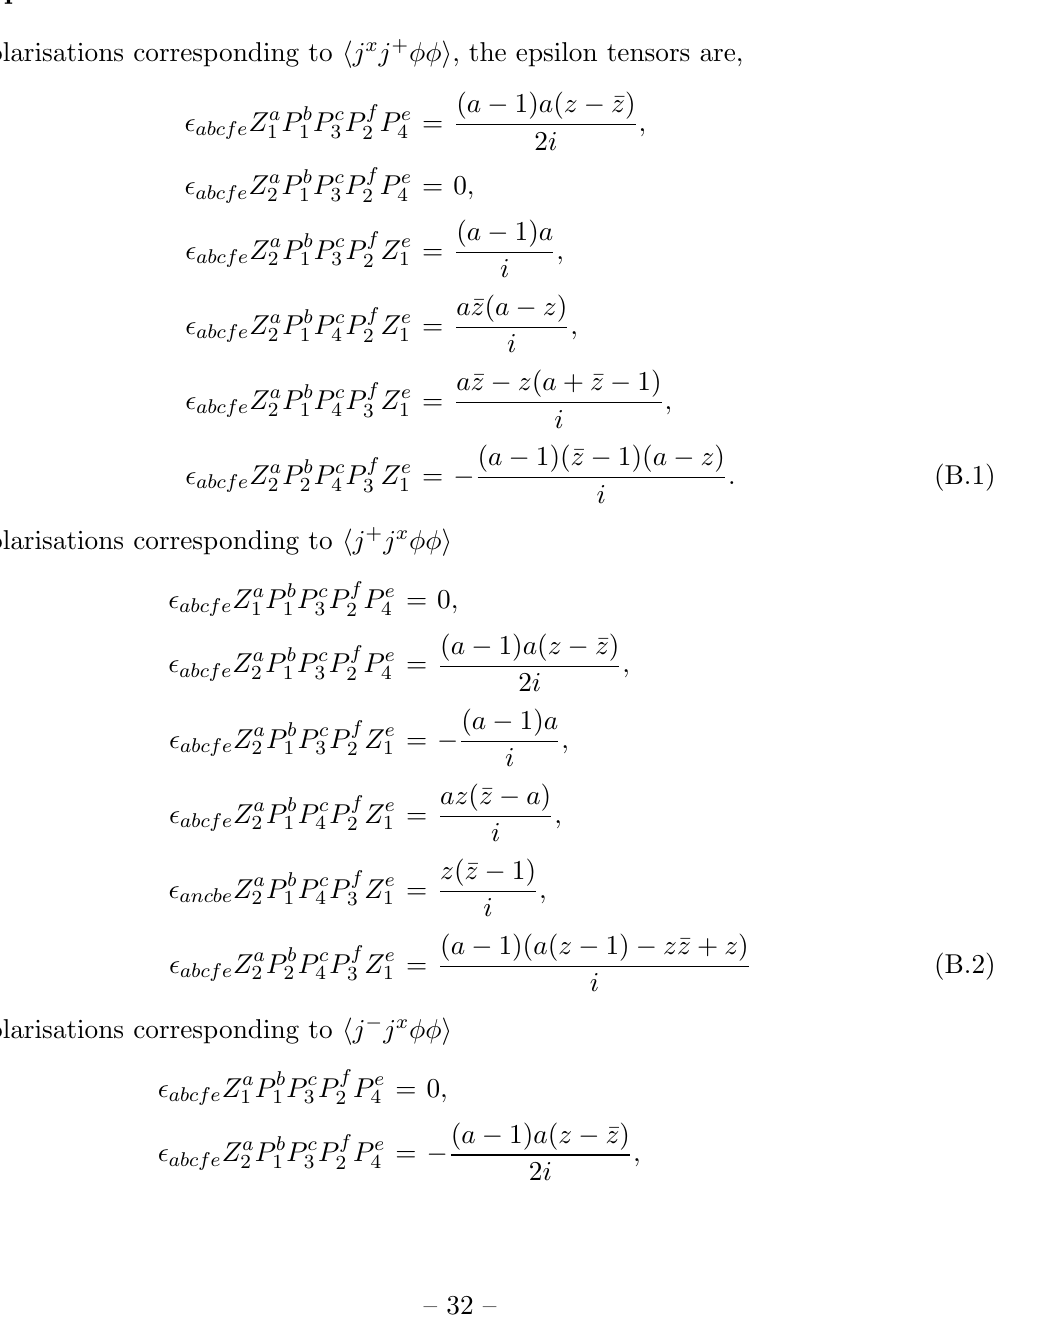
For polarisations corresponding to h j (cid:0) j x (cid:30)(cid:30)